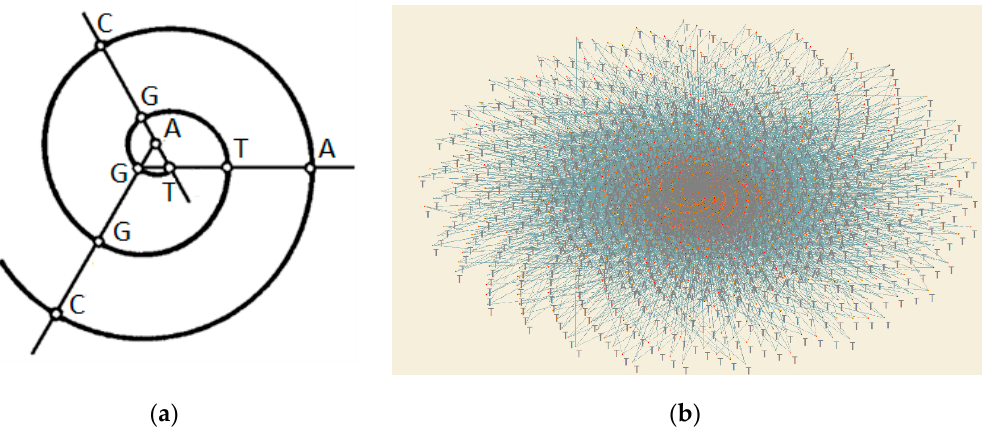
Figure 1. Nucleotides of DNA base present on Archimedean spiral and lung cancer rs10873142[C>T]. Figure 1. ( a ) Nucleotides of DNA base on Archimedean spiral; ( b ) DNA sequences of lung cancer rs10873142[C > T] on Archimedean spiral. Secondly, we transform Archimedean coordinates into Cartesian coordinates: